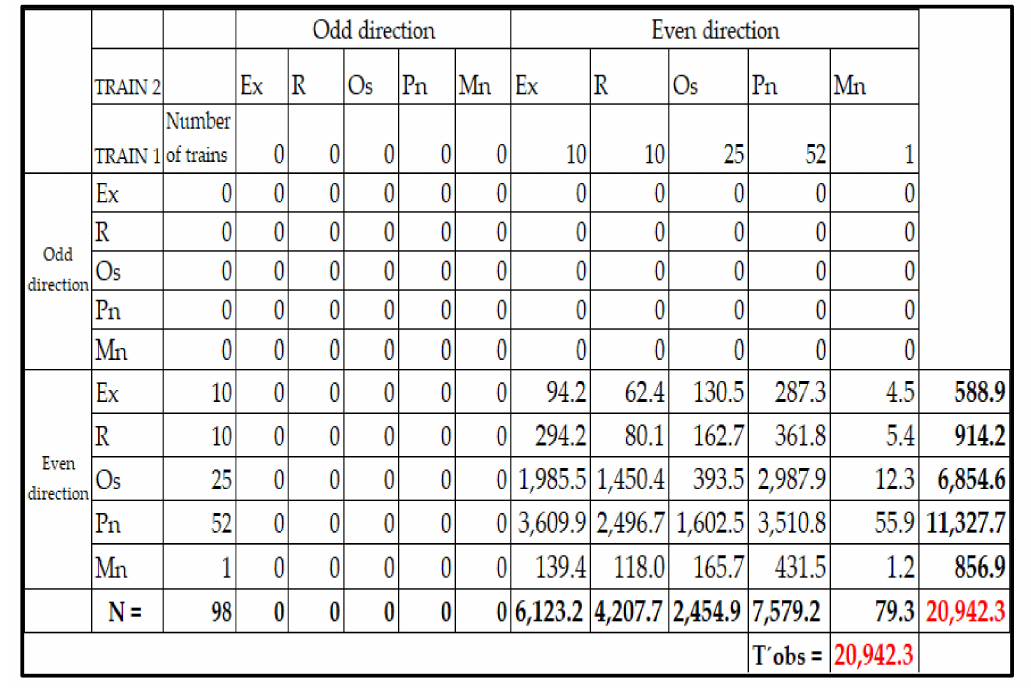
Figure 10. Resulting table with occupancy times of individual train sequences, ETCS L3 is shown for the even direction (ŽSR methodology). Table 3. Identified indicators of the practical throughput in the analyzed section, ETCS L3 for even